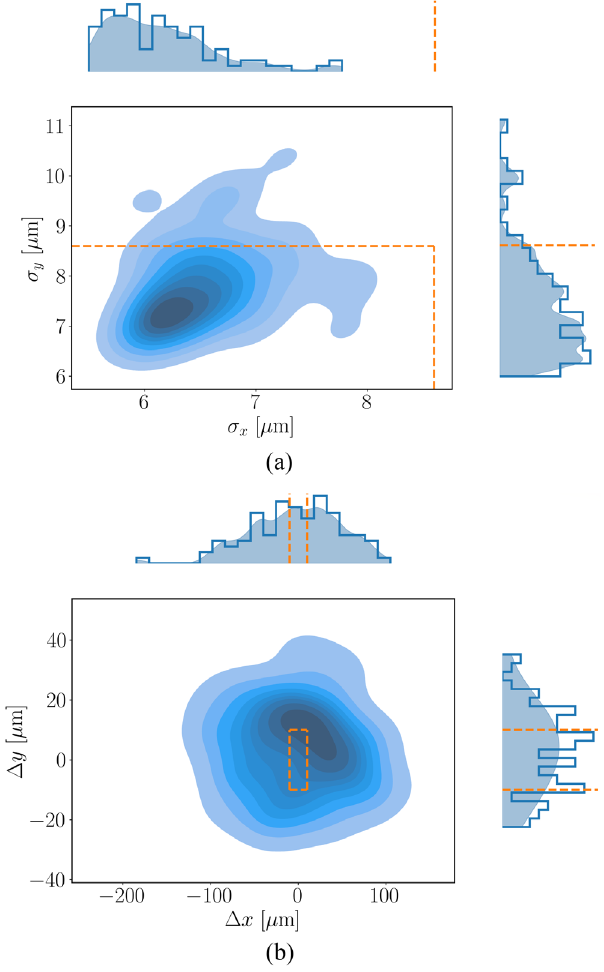
FIG. 10. Distributions of (a) beam sizes and (b) relative proton- electron transverse bunch offsets at the injection-point for 100 seeds with errors as defined in Table IV after beam-based align- ment. The orange lines denote the experimental